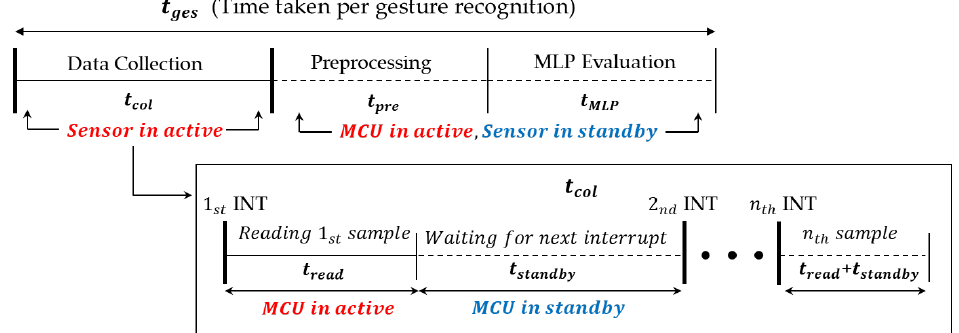
Figure 5. The routine (loop) that performs